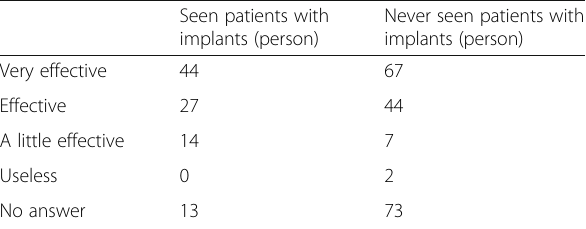
Table 7 Recognition on the effectiveness of implant card Seen patients with implants (person)